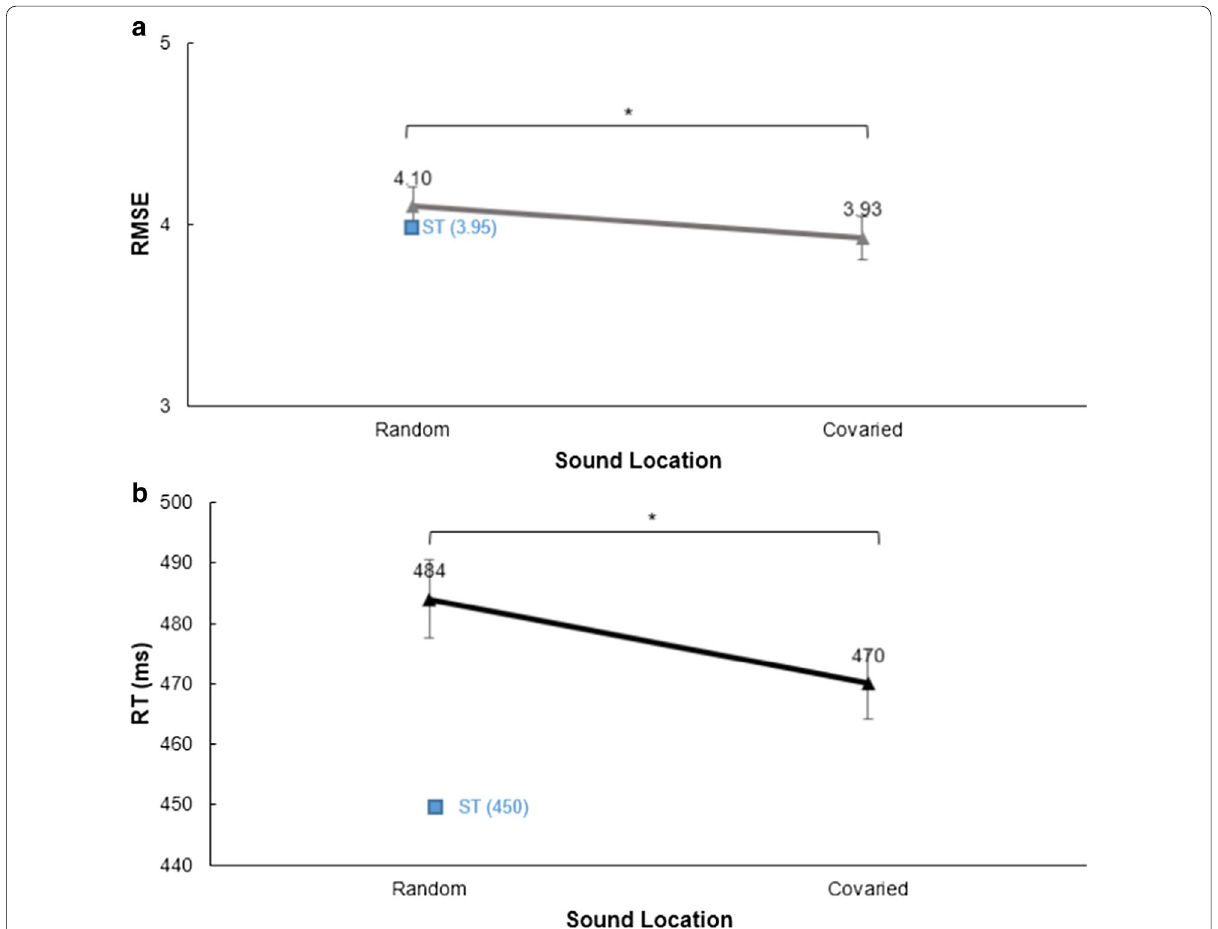
Fig. 10 Performance in Experiment 3 by covaried or random sound location. a Results of tracking performance for dual-task conditions in Experiment 3 as indicated by root-mean-square error (RMSE). b Reaction times (RTs) in milliseconds in dual-task conditions. In both panels, single-task (ST) performance is depicted by a single data point represented by a square